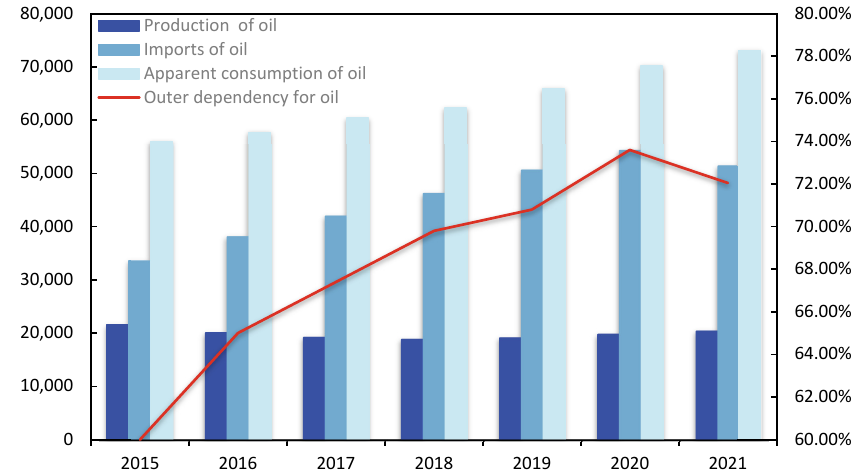
Figure 1. The supply and demand situation for oil in China. The international volatility of oil prices is the direct source of oil security issues [3]. China’s oil imports are too reliant on the Middle East, Russia, and other nations, as well as the majority of oil import channels being located in areas that are particularly susceptible to international political disputes. As seen in Figure 2, international crude oil prices fell fast in October 2018 and reached a new low in December, mostly owing to the diminished influence of the U.S. crude oil embargo on Iran on the international crude oil market and the continuous growth of U.S. crude oil stockpiles. Early in the year 2020, a global outbreak of Newcastle pneumonia disrupted global economic activity, depressed crude oil demand in April, and precipitated a precipitous decline in international oil prices. Early in 2022, the commencement of the Russia–Ukraine conflict as well as the application of multiple sanctions on Russia by the U.S. and several European nations led to a jump in international oil prices, which at one time reached USD 120 per barrel, a new high since 2008. The vast and dramatic variations in oil prices indicate that traditional oil geopolitical competition and games continue to exist, that the international market situation is complicated and unpredictable, and that China’s oil supply continues to be vulnerable to a number of unstable causes [4]. Consequently, it is of enormous practical importance to examine the effects of international oil price volatility on different sectors of the national economy.